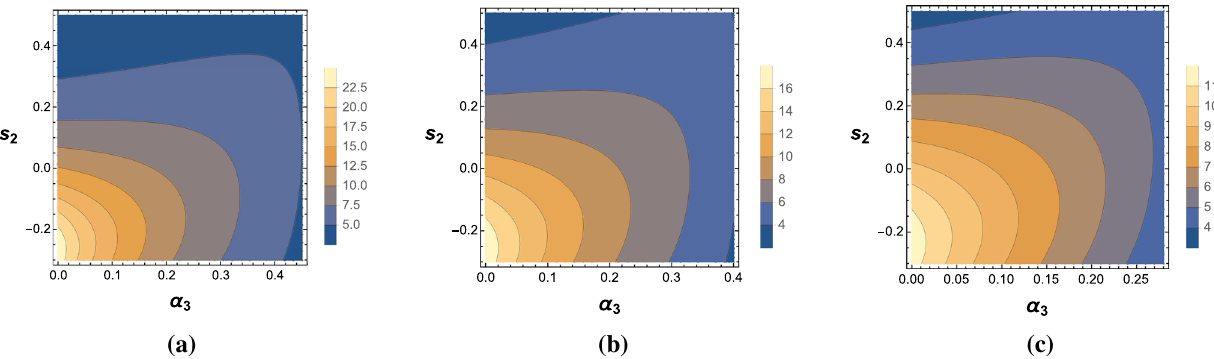
Fig. 2 The contour maps of E 3 in terms of α 3 and s 2 . a n = 0, b n = 0 . 3 and c n = 0 . 5 show that energy E 3 reaches its maximum value when both s 2 and α 3 are sufficiently small